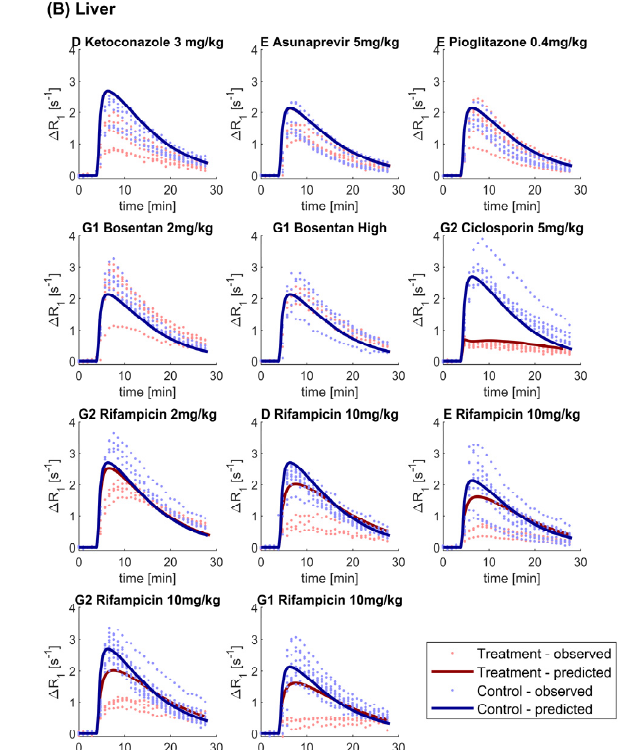
perpetrators (asunaprevir, bosentan, ciclosporin, ketoconazole, pioglitazone, and rifampicin) in plasma (Panel A ) and liver (Panel B ). Predictions using the gadoxetate physiologically-based pharmacokinetic model considered inhibition of both CL uptake and CL biliary , assuming unbound plasma concentrations to drive inhibition of each transporter parameter. Doses for each drug are listed in Table 1; “Bosentan High” refers to the 4–6 mg/kg doses of bosentan.